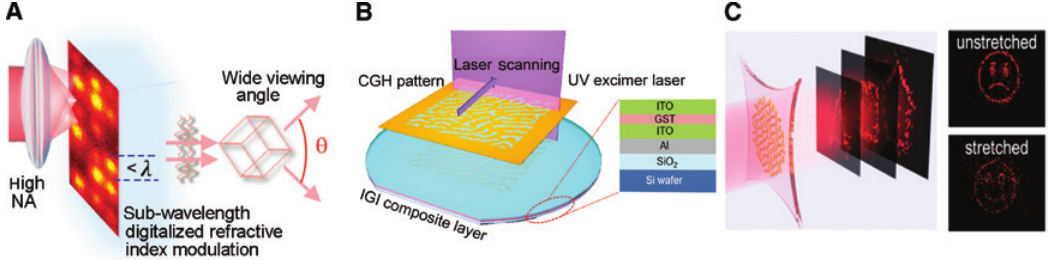
Figure 9: Active metasurface holography. (A) Active metasurface hologram composed of the functional graphene oxide materials for achieving 3D holography with wide viewing angles, which is rewritable by pumping with femtosecond laser pulses [40]. (B) Active metasurface hologram integrated with the phase change material GST, which can be switched between the crystallization or amorphous state [41]. (C) Mechanically stretchable metasurface hologram for switchable image reconstructions at a fixed plane [101]. Reprint permission obtained from [40, 41,